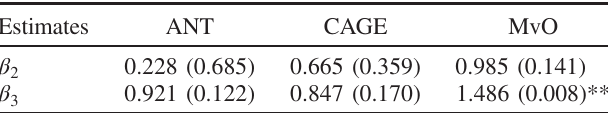
Because ordinal data such as ours cannot be averaged, we TABLE VI. Estimated coefficients and associated p values (in